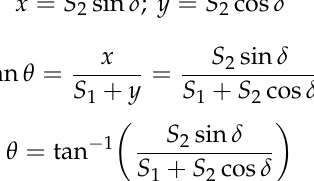
using trigonometric functions (5) and (6).